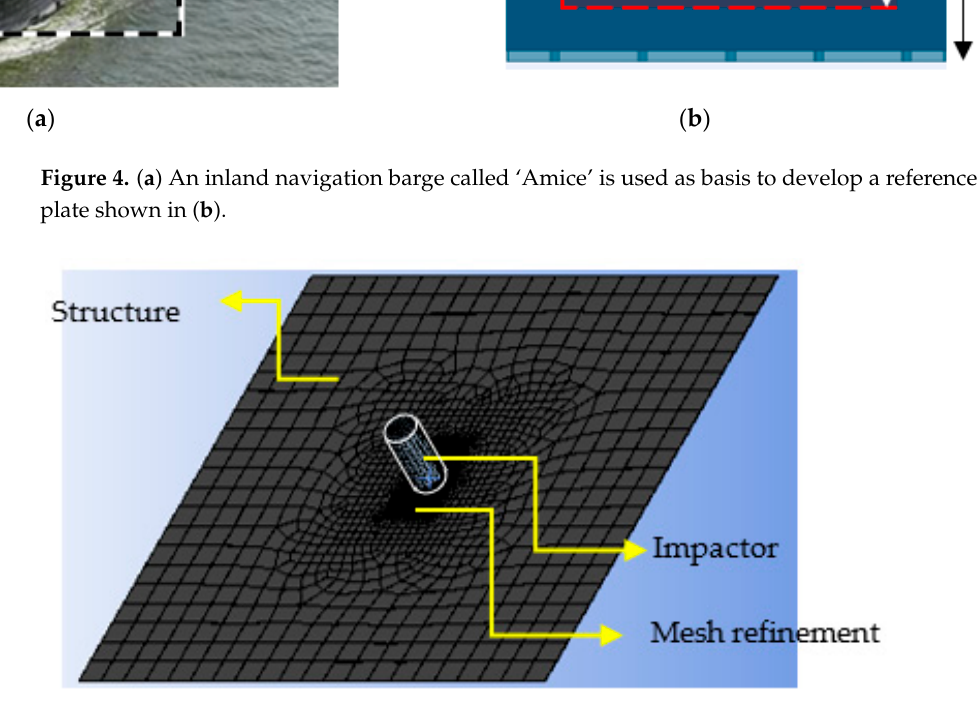
Figure 5. Panel mesh arrangement with impactor.